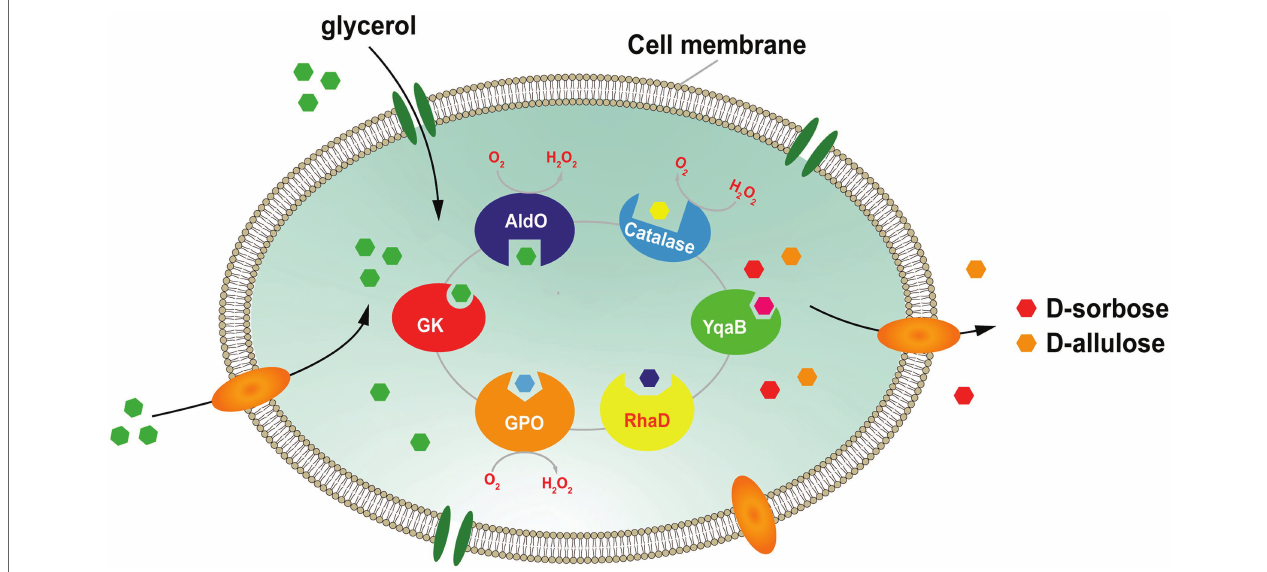
FIGURE 7 | Strategy for the whole-cell synthesis of D-sorbose and D-allulose from glycerol. GK, glycerol kinase; GPO, glycerol oxidase; AldO; alditol oxidase; RhaD, L-rhamnulose-1-phosphate aldolase; YqaB, fructose-1-phosphatase.